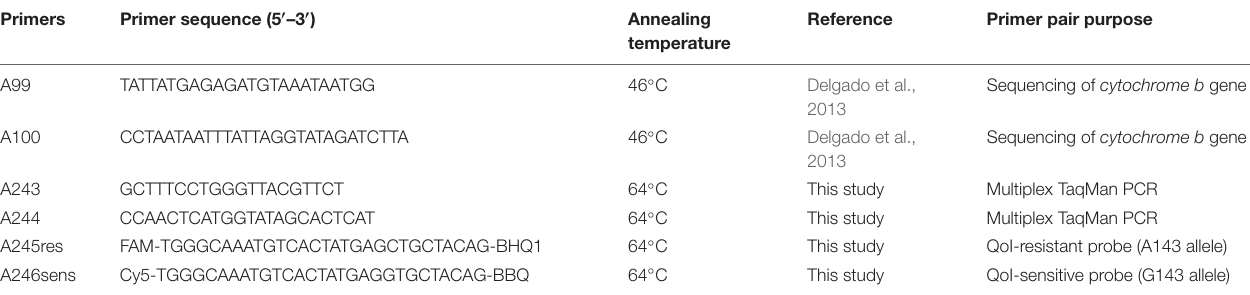
TABLE 2 | Primers pairs used for amplification of the cytochrome b gene fragment of Didymella rabiei and for detecting the G143A mutation. Primers Primer sequence (5 (cid:48) –3 (cid:48) )